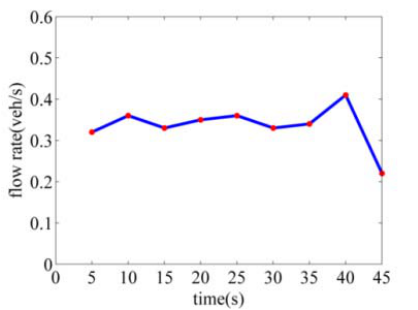
Fig.4 With a 130m Stretching-segment